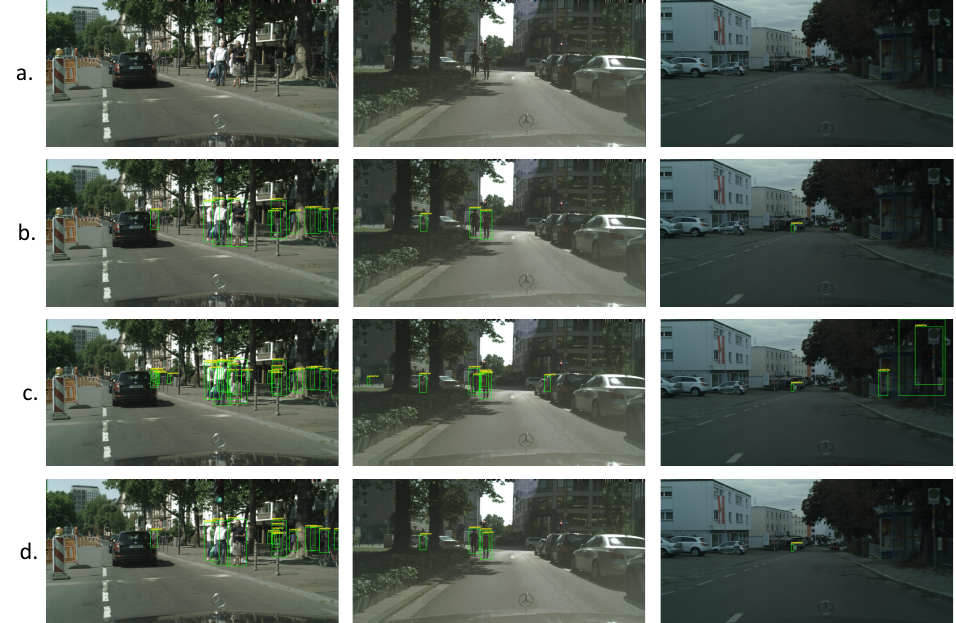
Figure 6. Visualization results of CCFNet and CSP do not limit the visibility of pedestrian objects. ( a ) Input the original image for the CityPersons dataset; ( b ) is the ground truth corresponding to ( a ); ( c ) is the visualization result of CSP; ( d ) is the visualization result of CCFNet.